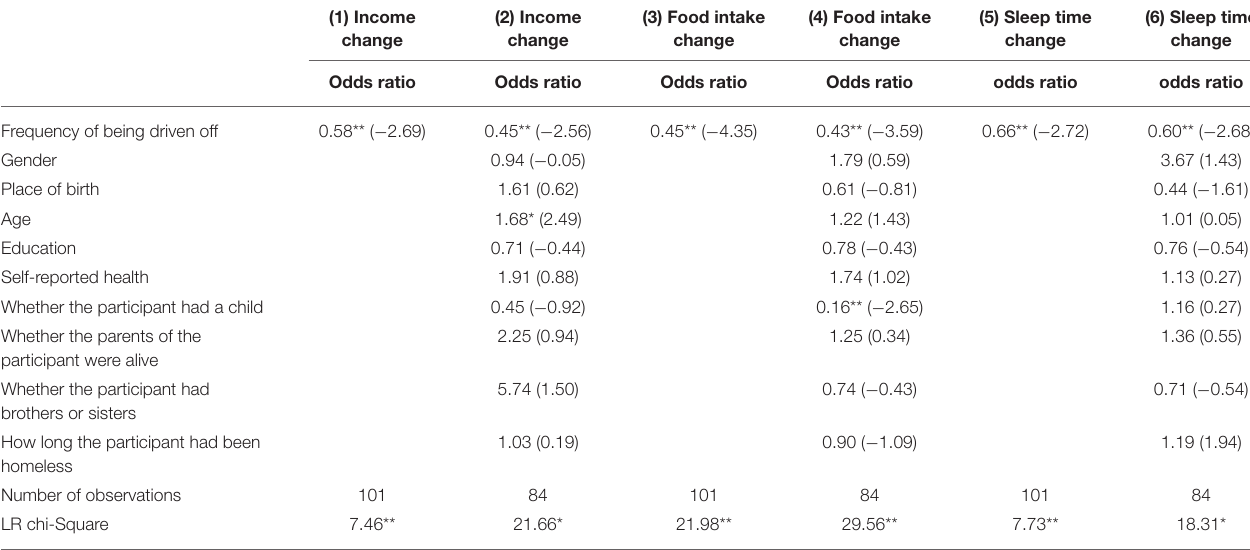
TABLE 4 | The ordered logit regression results estimating the effect of inhumane efforts of the government to drive the homeless away on the lives of homeless people (income, food intake, sleep